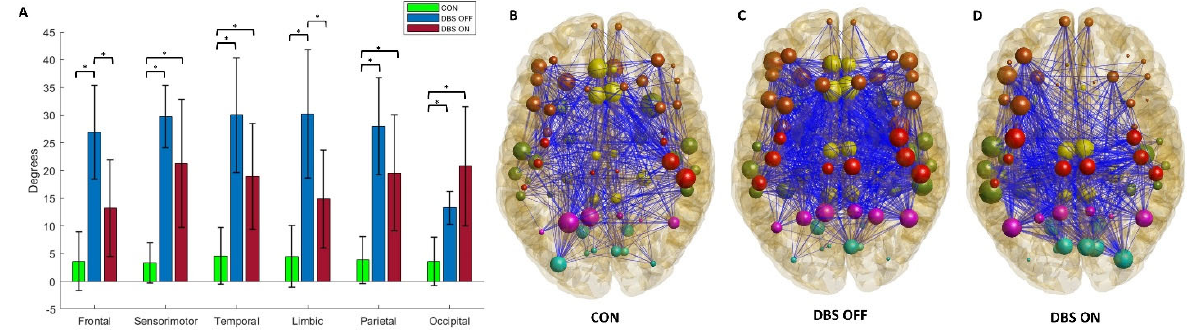
Figure 3. Box graph ( A ) of nodal degrees of each brain lobe in HC and PD patients in STN-DBS-OFF and STN-DBS-ON states. * indicates a statistically significant difference ( p < 0.05). Graph representation of whole-brain network based on wPLI in β frequencies in HC ( B ) and PD patients in STN-DBS-OFF ( C ) and STN-DBS-ON ( D ). Table 3. Lobar nodal degrees in controls and PD patients, in both DBS ‐ OFF and DBS ‐ ON. Lobe